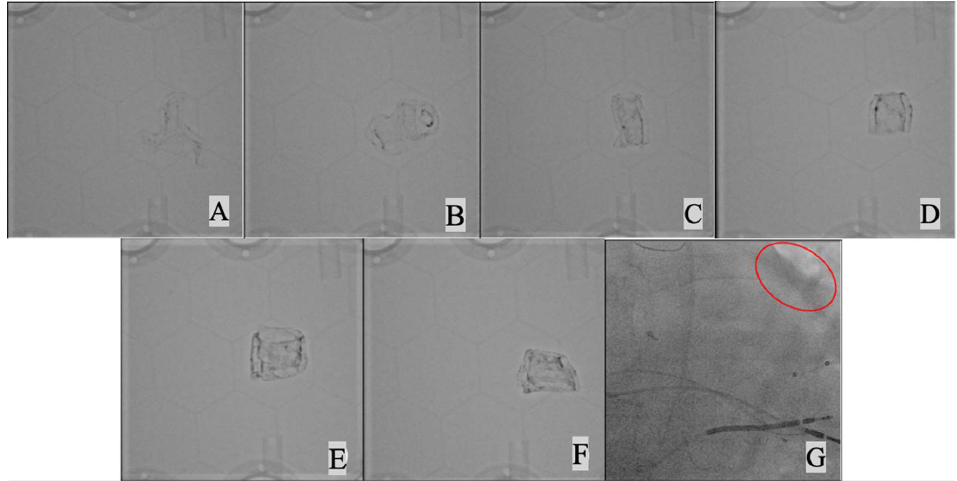
Figure 4. X-ray imaging of Layfomm-40 cylinders coated with UAP mixed with increasing amounts of BaSO 4 . ( A ) mass ratio15:1 UAP:BaSO 4, ( B ) 15:2, ( C ) 5:1, ( D ) 15:2, ( E ) 3:1, ( F ) 5:2, and ( G ) clinical image showing the left heart border (red